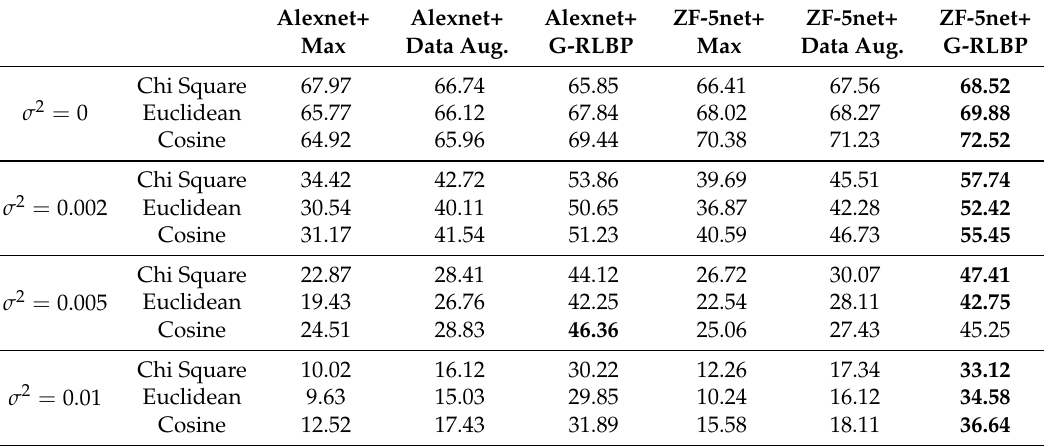
Figure 11. The feature maps of different pooling layers in the Alexnet. Conv1 indicates the first convolutional layer in the networks. ( a ) The output of Pool1 layer without injecting any noise into the input image in the baseline Alexnet; ( b ) the output of Pool1 layer in the baseline Alexnet when the input image is injected with Gaussian noise ( σ 2 = 0.005); and ( c ) the output of the G-RLBP pooling layer when the input image is injected with the same noise as ( b ). Table 6. The recognition rates (%) of different pooling methods and data augmentation based on the Alexnet and ZF-5net on the AR database with different Gaussian